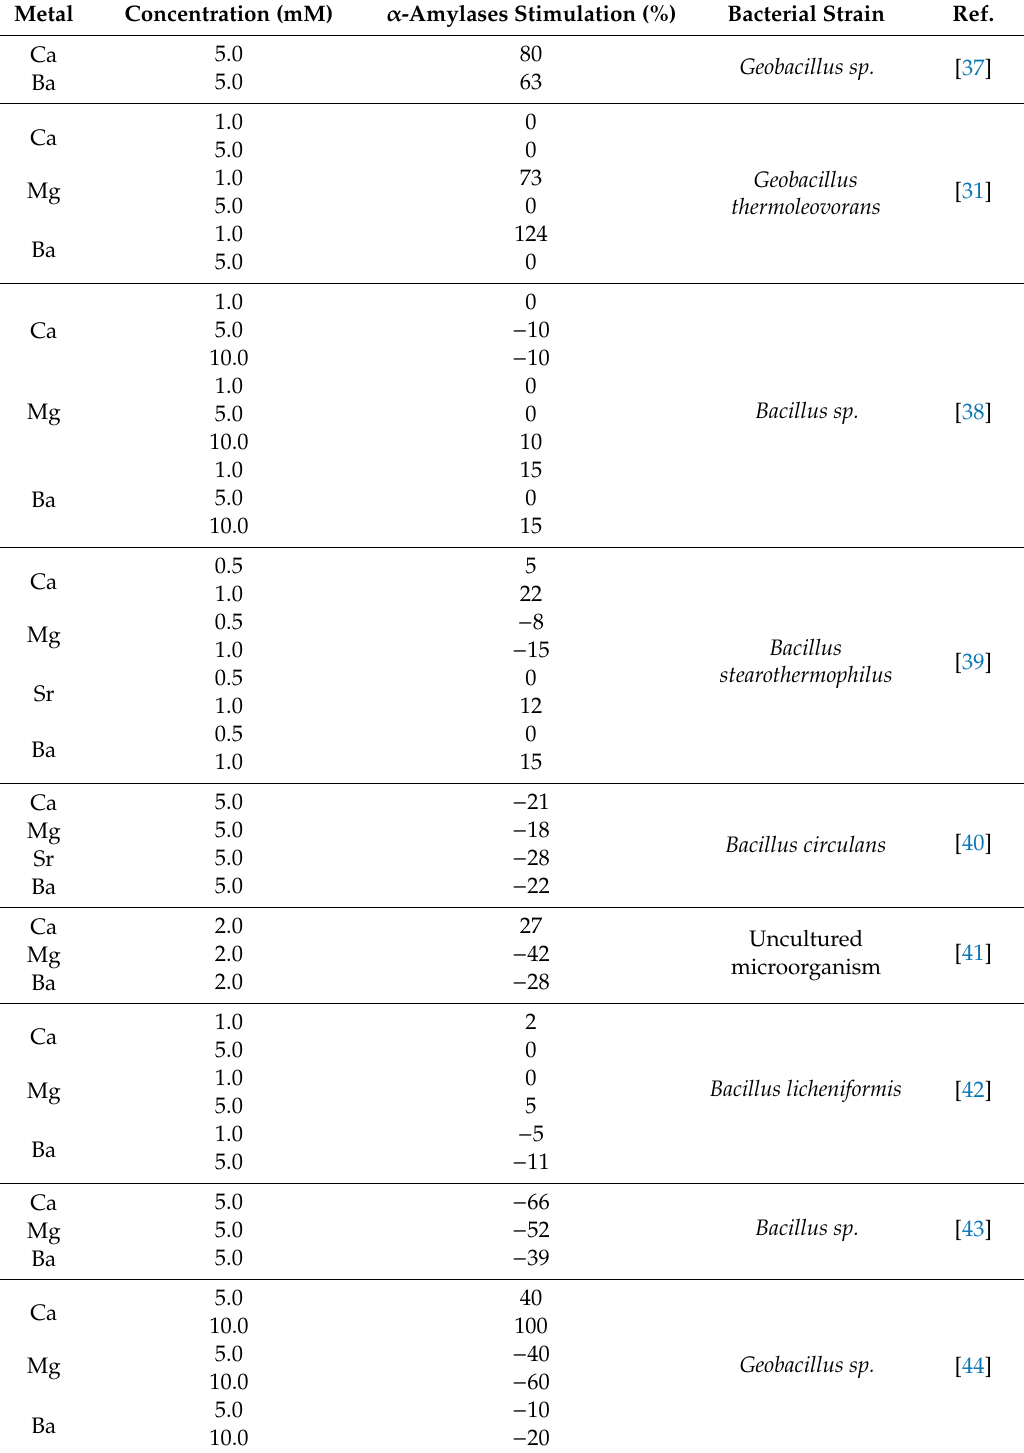
Table 2. E ff ect of alkaline earth metals over enzymatic activity of pure bacterial α -amylases.